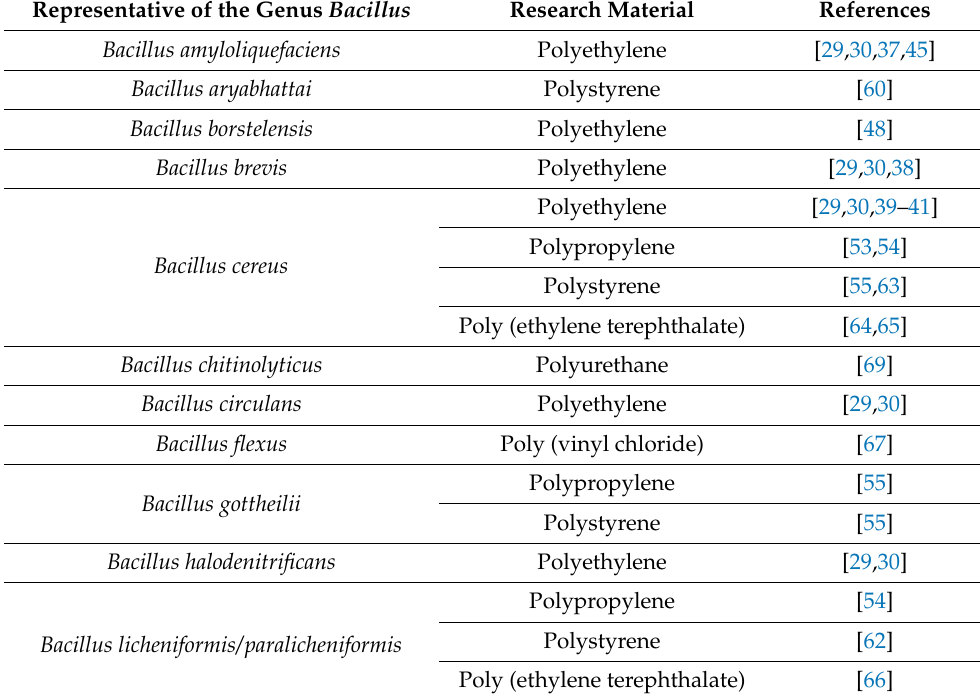
Table 5. Diversity of bacteria of the genus Bacillus , which are involved in the biodegradation of synthetic